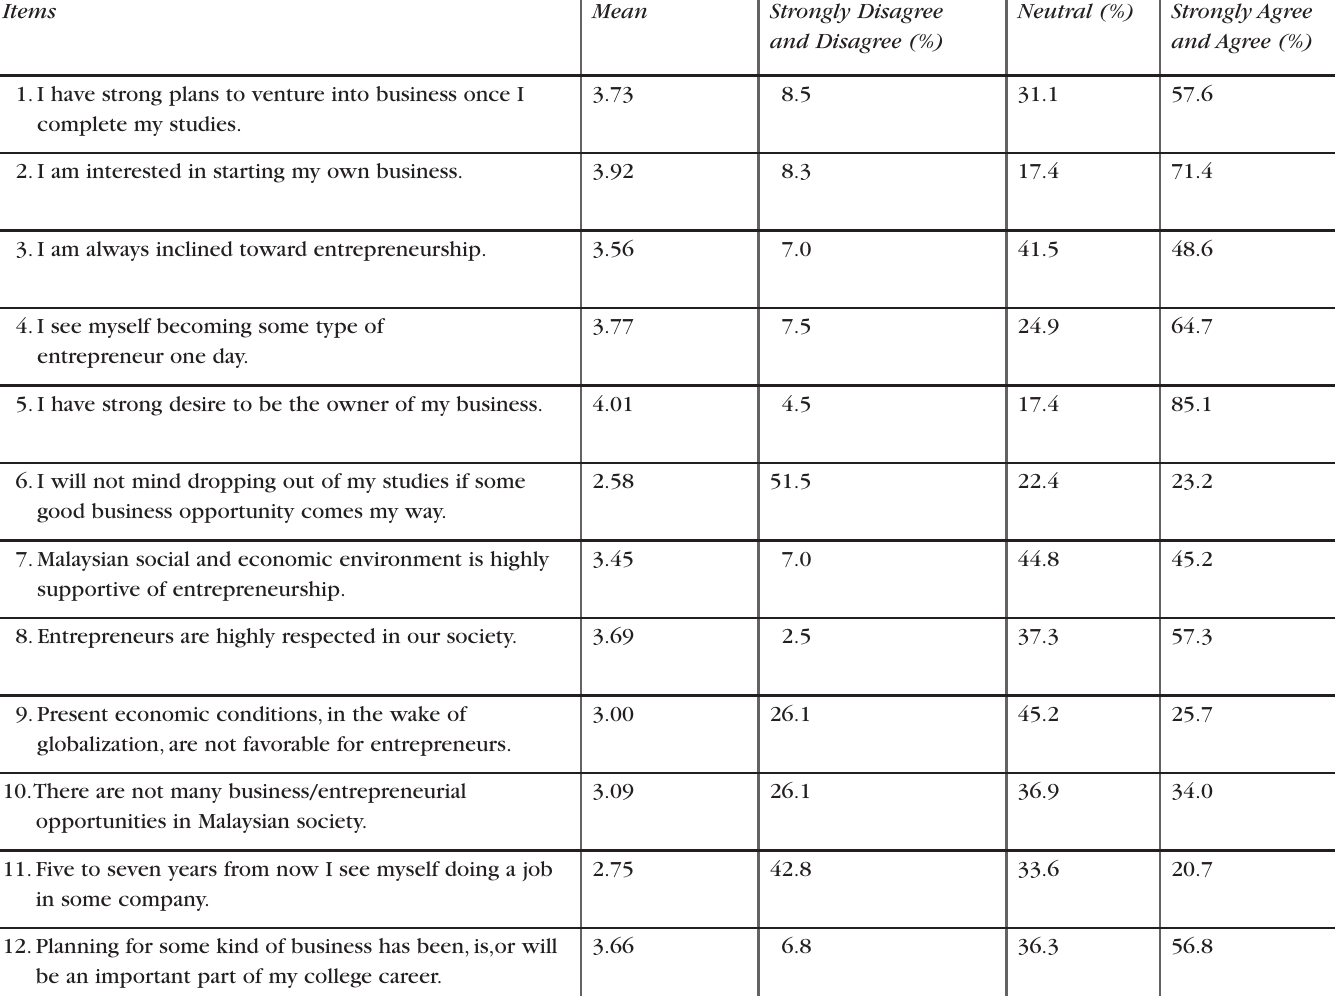
Table 3. Mean and Frequency Distribution of Responses (n = 234) Items Mean Strongly Disagree Neutral (%) Strongly and Disagree (%)